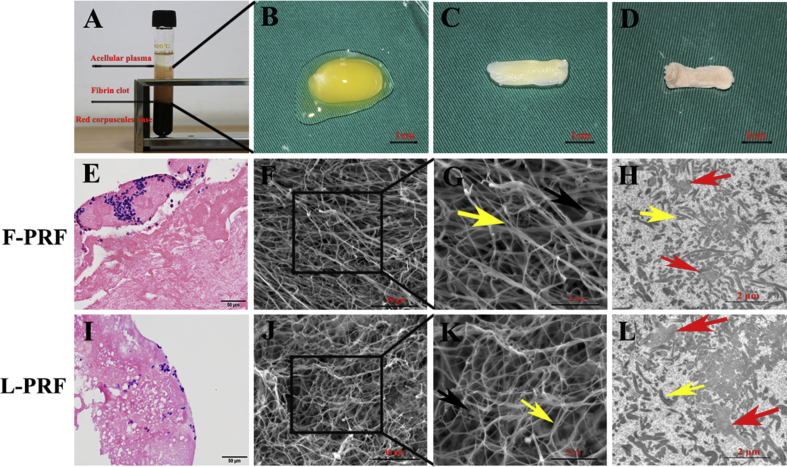
Characterization of L-PRF and F-PRF. (A) Blood samples were divided into three layers after centrifugation for 10 min at 3000 rpm. The top layer of pale yellow liquid was acellular plasma, the bottom layer of loose red jelly was the red blood cell layer, and the pale yellow gel in the middle contained fibrin clots. (B) A PRF clot was easily obtained when the acellular plasma and red blood cells were removed (scale bar = 1 cm). (C) A compact, flexible and strongly elastic fibrin membrane, which was considered to be F-PRF, was obtained by removing the fluids trapped within the fibrin matrix (scale bar = 1 cm). (D) After lyophilization, L-PRF with a rough surface and loose structure was collected (scale bar = 1 cm). (E) H&E staining revealed that F-PRF consisted of a large number of closely arranged red-stained fiber bundles containing numerous blue-stained nuclear leukocytes (scale bar = 50 μm). (I) The fibrin network of L-PRF was loosely arranged with numerous pores containing many well-distributed blue-stained nuclear leukocytes (scale bar = 50 μm). (F, J) SEM examination showed that fibrin was arranged regularly in the F-PRF (F), whereas the arrangement of fibrin in the L-PRF was disordered (J) (scale bar = 10 μm). (G, K) High-magnification SEM images showed the three-dimensional network of PRF, which consisted of a large number of trimolecular branch junctions (yellow arrow, G) with fibrin fibers and some fibrillae with a smaller diameter (yellow arrow, K) in both F-PRF (G) and L-PRF (K). Among the fibrin fibers, a few platelets were also observed (black arrow, scale bar = 5 μm). (H, L) TEM examination also demonstrated that both F-PRF (H) and L-PRF (L) consisted of numerous fibrin bundles (yellow arrow). The α-granules of platelets in the F-PRF (H) were maintained intact, and each platelet was tightly adhered to several fibrin bundles (red arrow, H). However, some α-granules of the platelets in the L-PRF were damaged, and part of the platelet membrane structure vanished (red arrow, L). The platelets were slightly larger and swollen and staining was very weak in the L-PRF (L) compared with the F-PRF (H) (scale bar = 2 μm). These results suggested that freeze-drying had little effect on the structure of PRF.